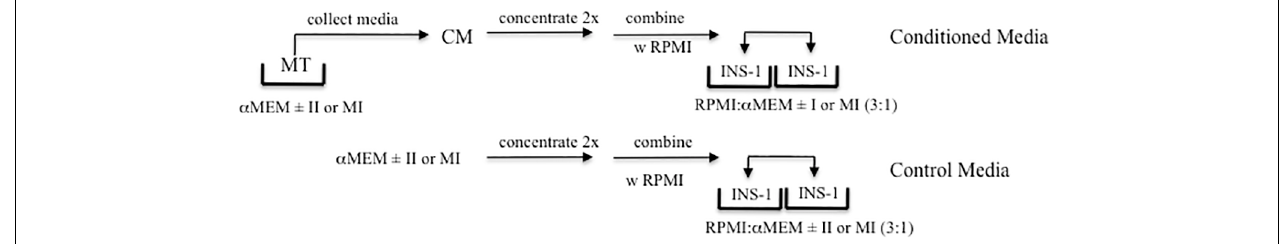
FIGURE 1 | Experimental Design. Schematic representation of the production of MT conditioned (CM, top) and control (lower) media, and treatment of INS-1 cells.